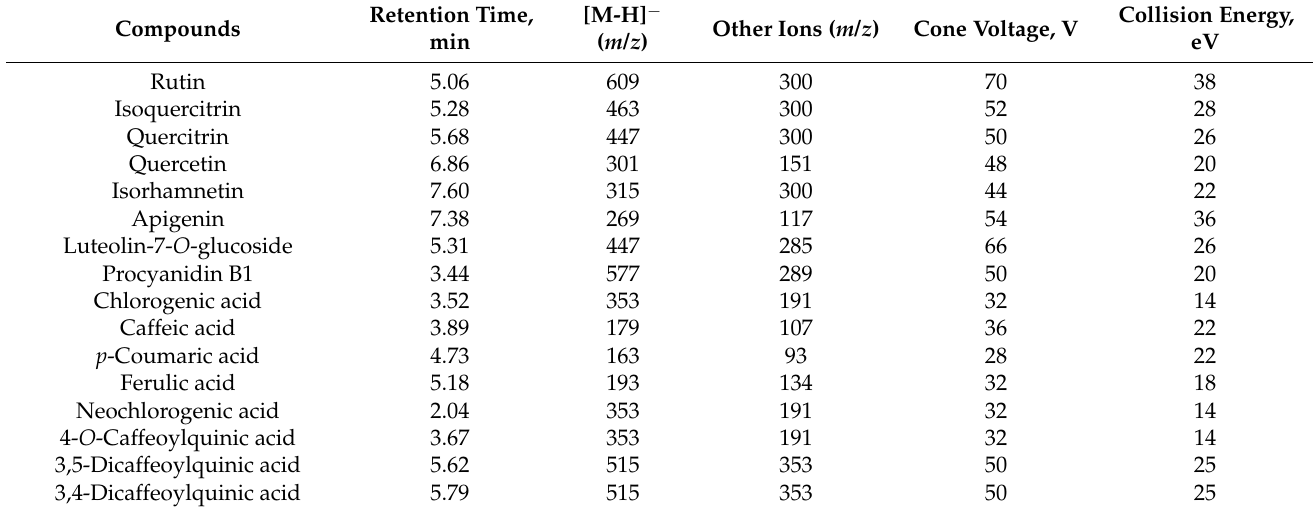
Table 6. UPLC-ESI-MS/MS (negative ionization mode) data of flavonoids and phenolic acids determined in extracts of L. caerrulea